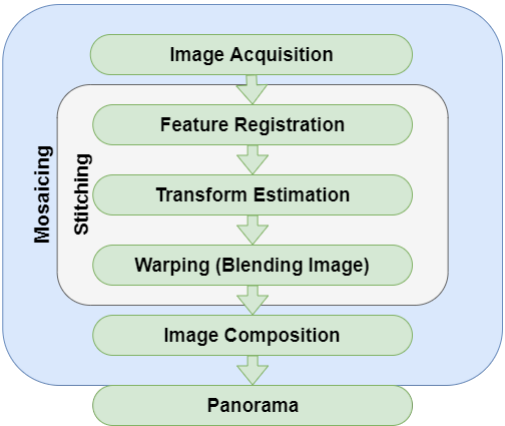
Figure 1. Mosaicing